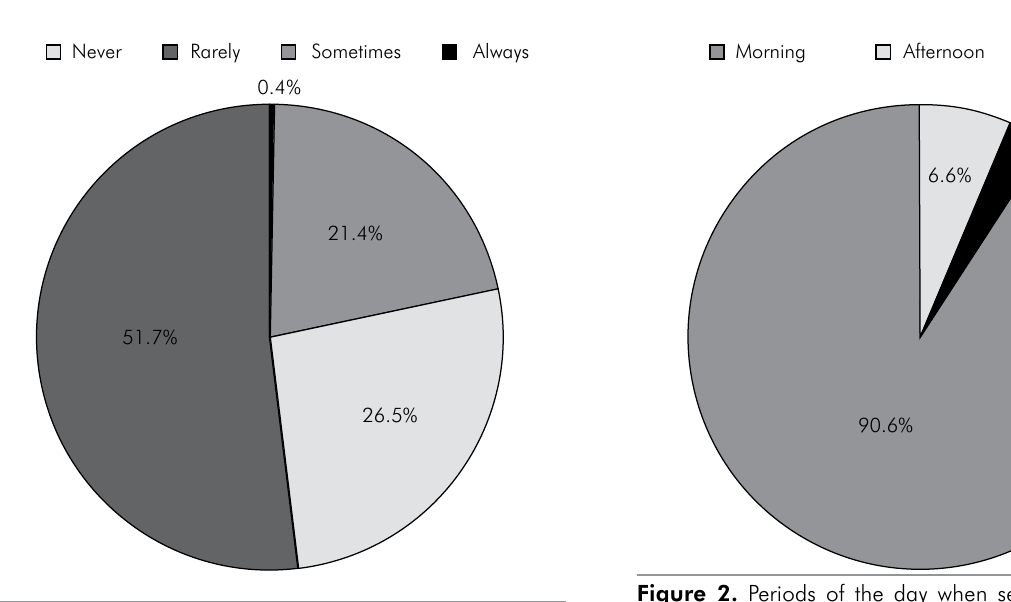
Figure 1. Occurrence of self-reported halitosis in the sample.